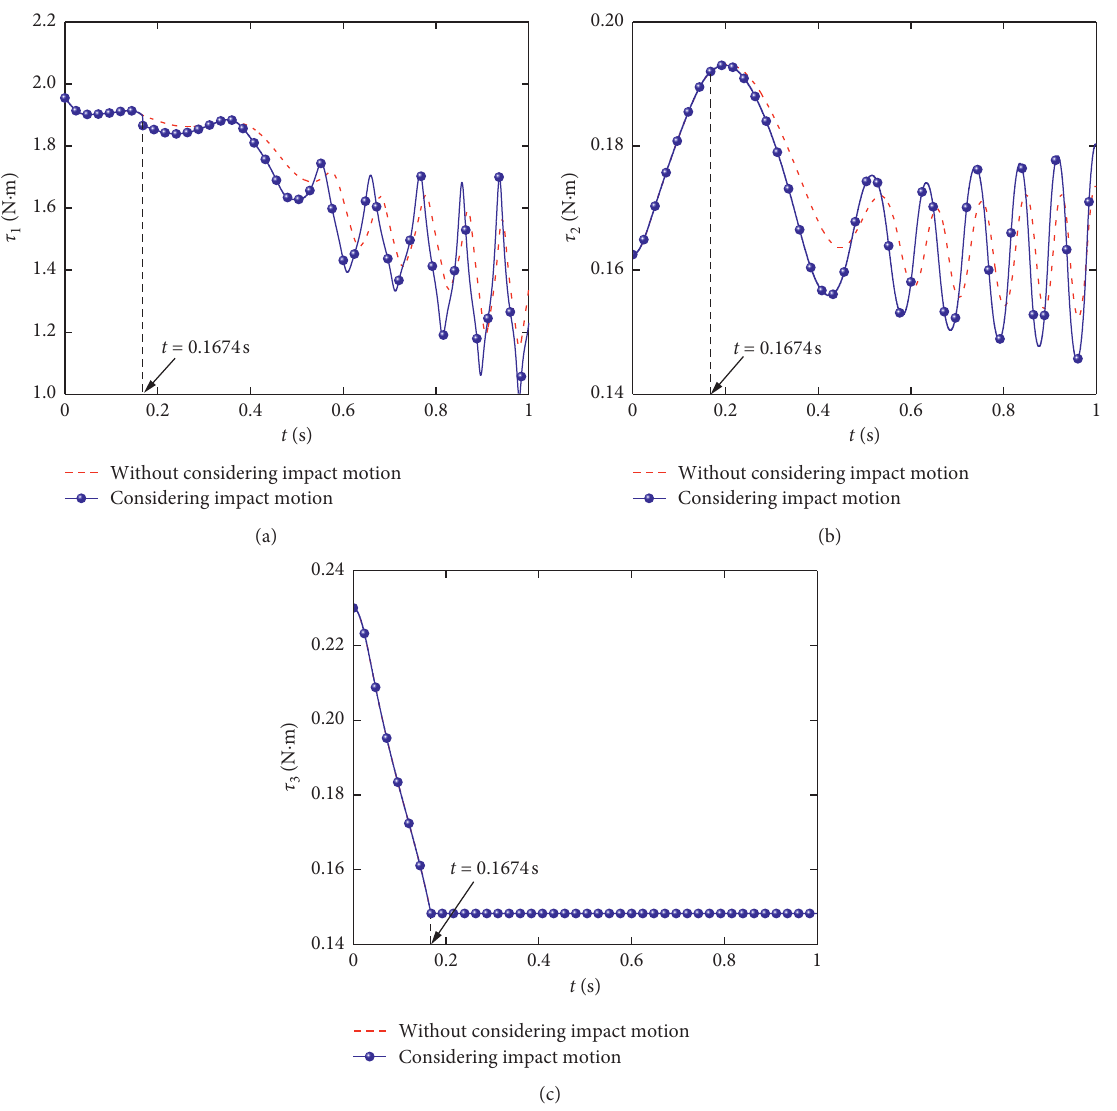
Figure 8: Moment simulations of the joints. (a) Moment variation of joint O joint O 3